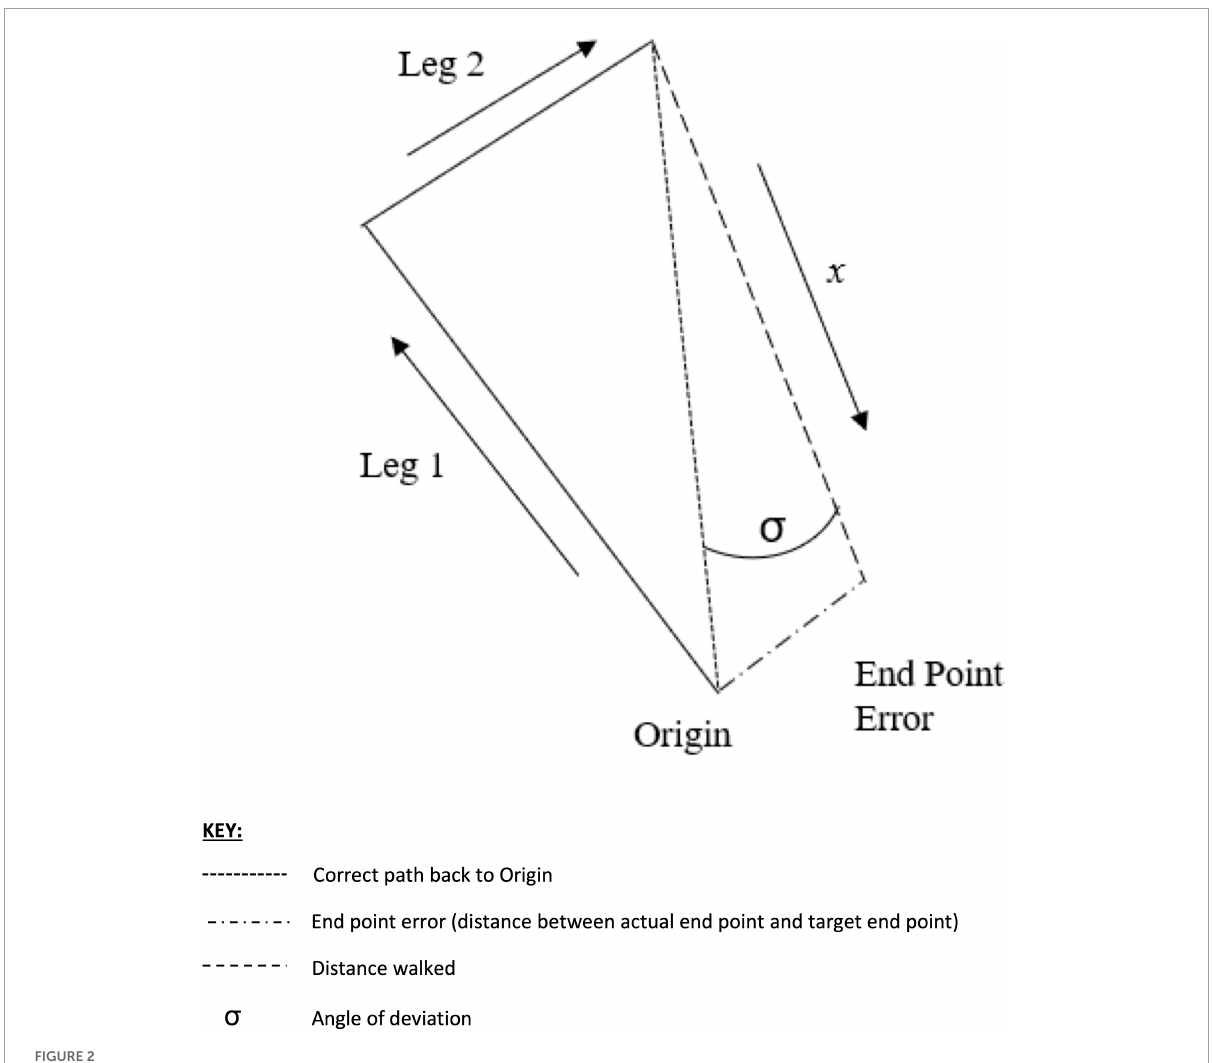
FIGURE2 Visual representation of the triangle completion